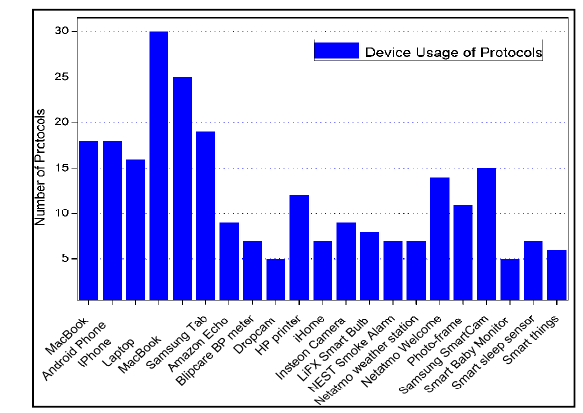
Fig. 7: Number of Protocols used by Devices